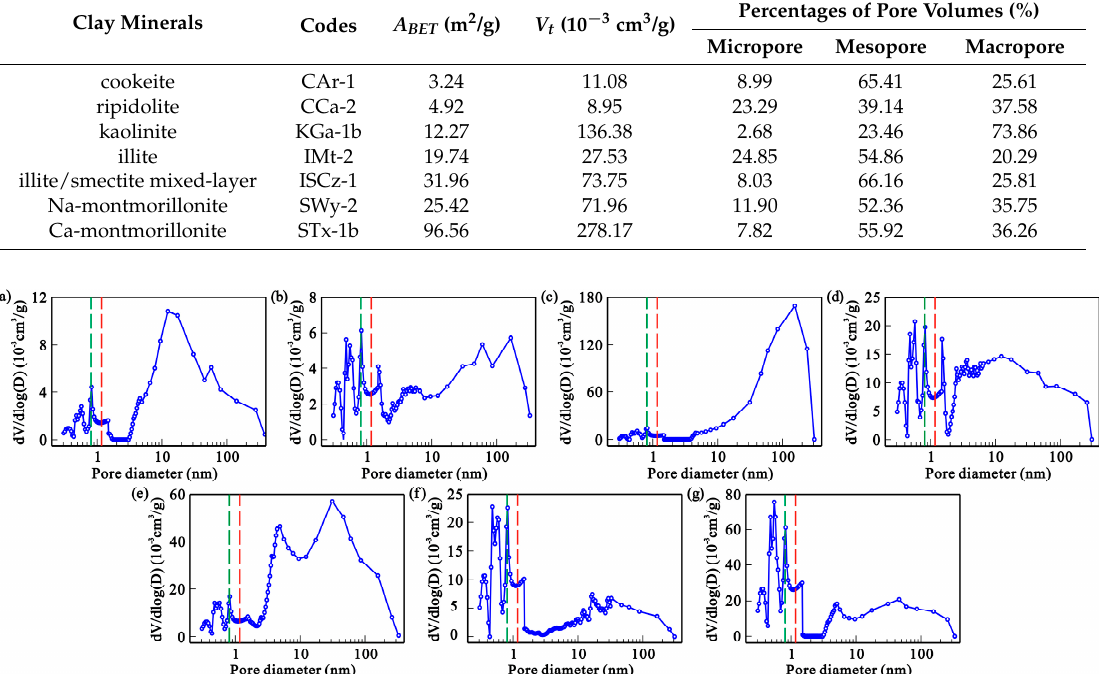
Table 2. BET surface areas ( A BET ), total pore volumes ( V t ) and the percentages of pore volumes from micropore, mesopore and macropore.